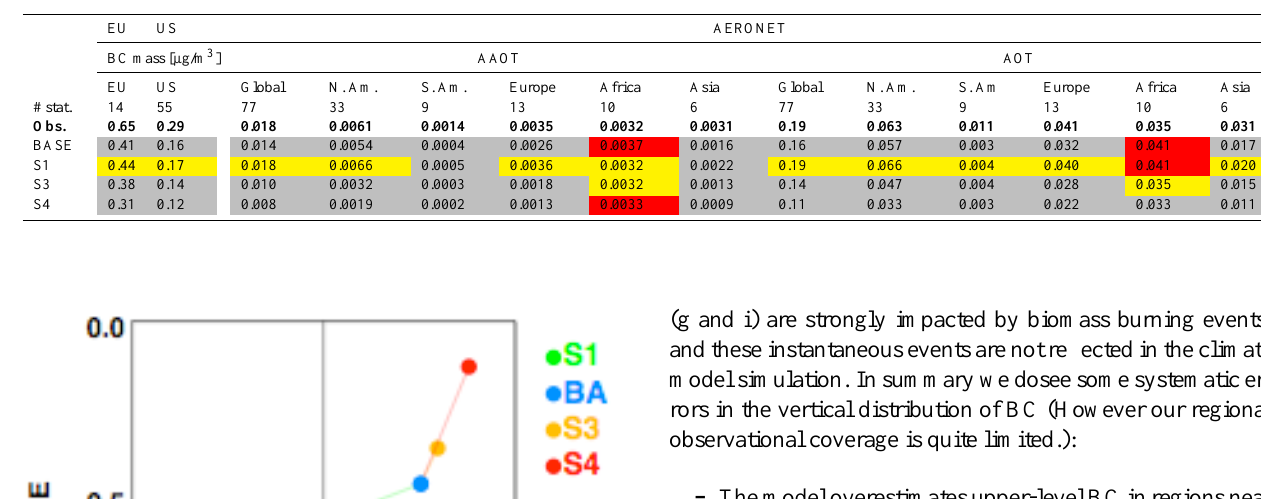
Table 4. Comparison between model simulations and EMEP (EU) and IMPROVE (US) measured surface BC concentrations, and AERONET absorption optical thickness (AAOT) and optical thickness (AOT). Year 2000 AERONET data are used. Model data are averaged at station locations. Gray shadings mark model values that are lower than the observation, red shadings show higher modeled values, and yellow shading indicates best simulation. Global and regional comparisons are presented for, North America, South America, Europe, Africa (including Arabian peninsula) and Asia.